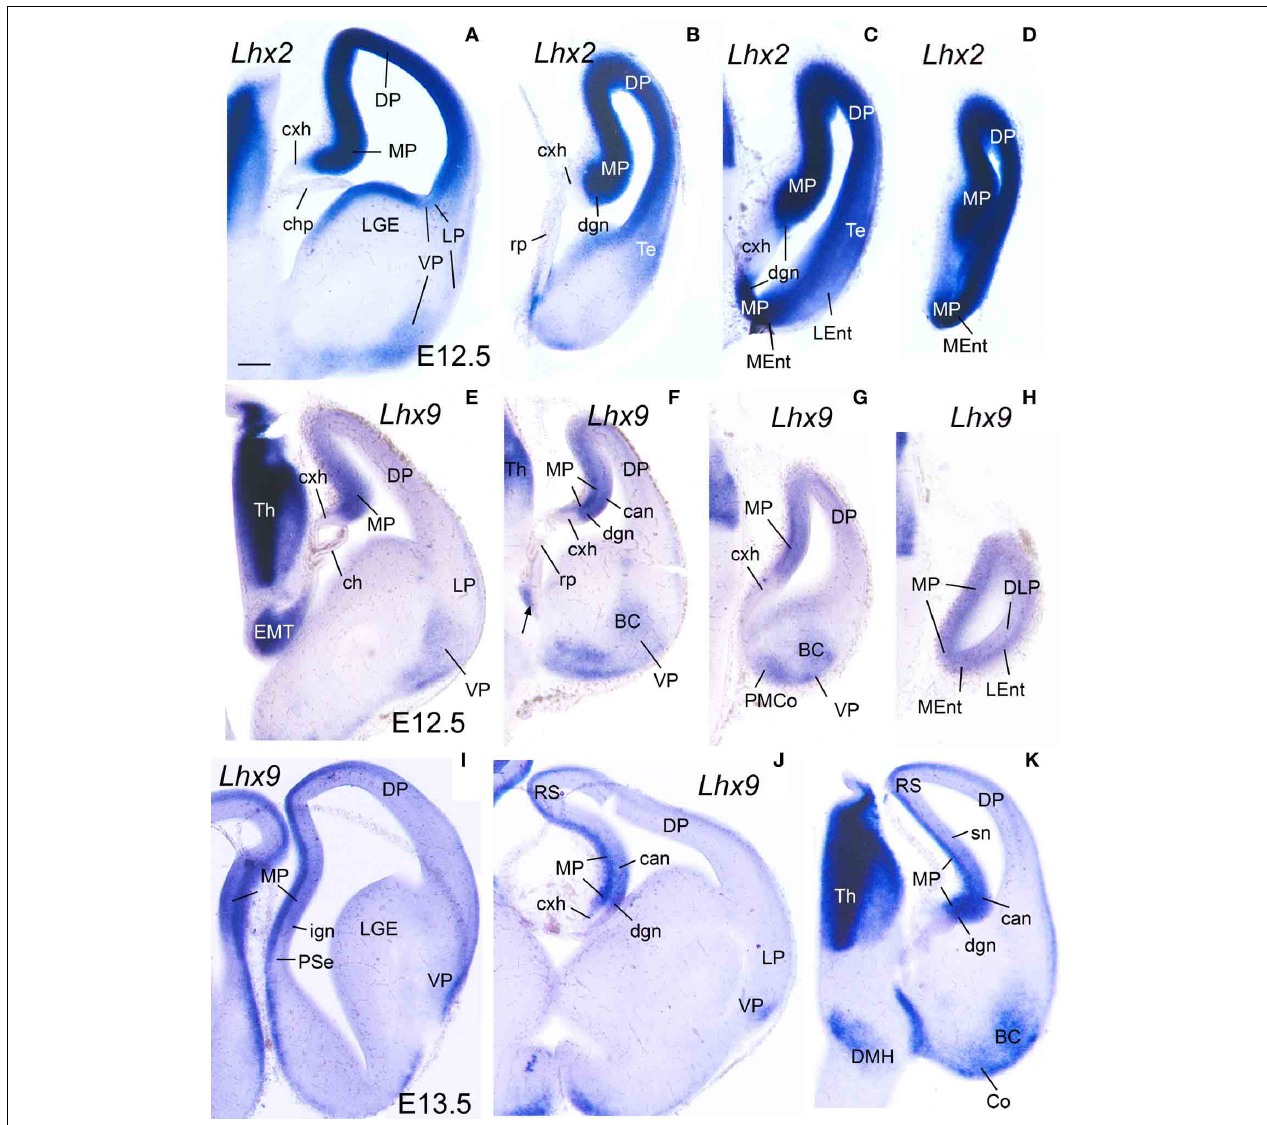
FIGURE 2 | Expression of Lhx2 and Lhx9 in mouse embryonic telencephalon at early stages. Digital images of coronal sections of mouse embryonic telencephalon ( A–H : E12.5; I–K : E13.5), from intermediate (left panels) to caudal (right panels) levels, hybridized for Lhx2 (A–D) or Lhx9 (I–K) . Note the strong expression in the ventricular zone of the medial pallium. As noted previously, Lhx9 is also distinctly expressed in ventral pallial